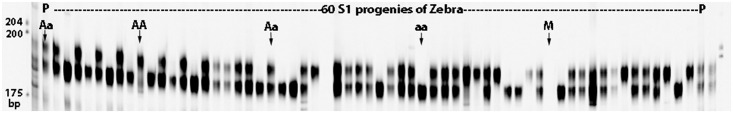
A gel image of ‘Zebra’ common bermudagrass and its 60 progenies amplified with SSR CDGA8-1765/1766.The band pattern of Zebra (P) was coded as “Aa”, and a progeny band pattern coded as “AA” if one upper band, “Aa” if two bands, and “aa” if one lower band. A missing lane was labeled as ‘M’. Standard size markers were loaded on first and last lanes.